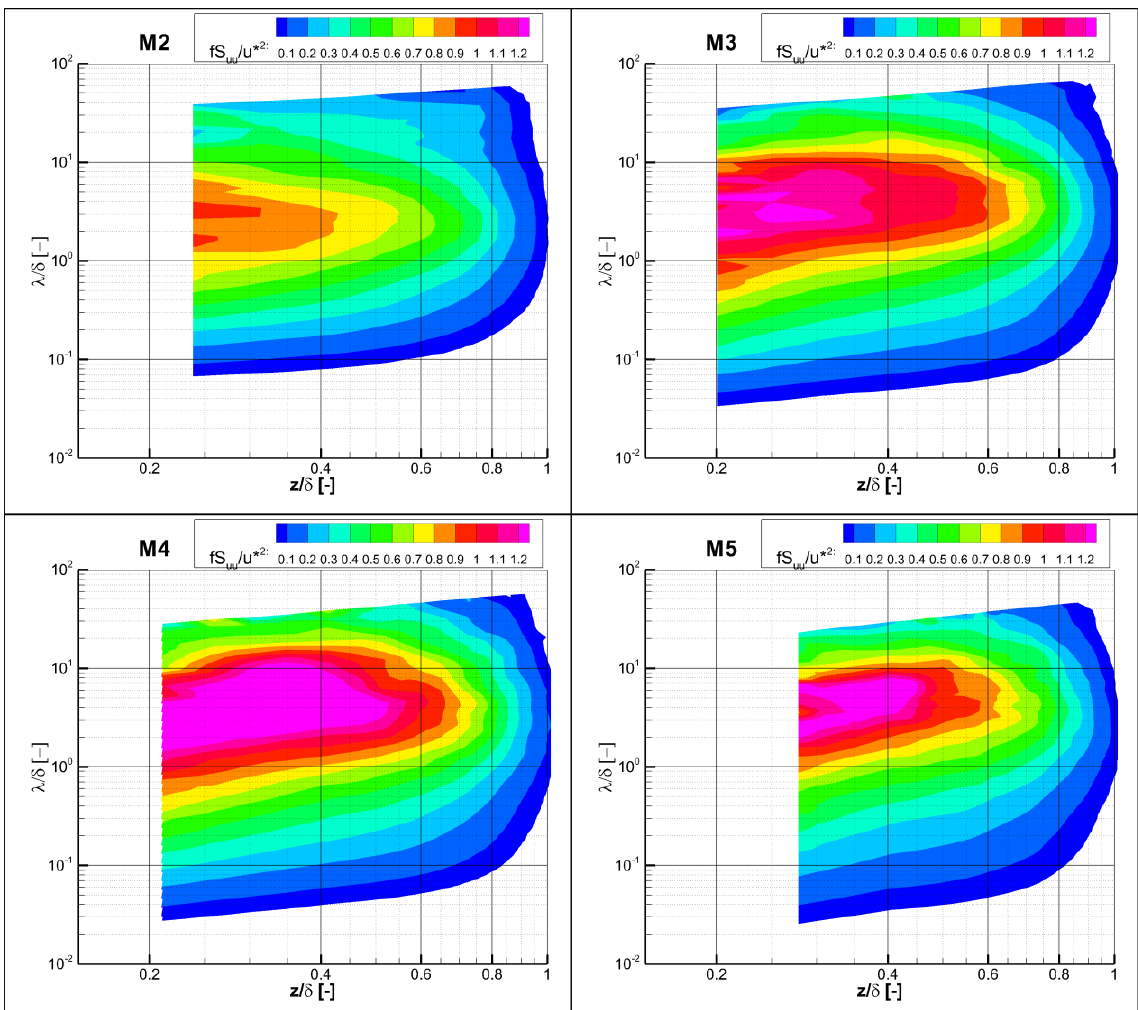
Fig. 5. Spectrograms for all setups based on the HW data. M2 Re τ =1300, M3 Re τ =3110, M4 Re τ =4270, M5 Re τ